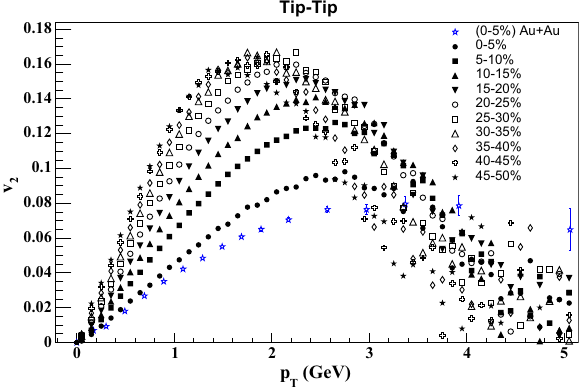
Fig. 22 Variation of elliptic flow ( v 2 ) with respect to p T in tip–tip configuration for various centrality classes